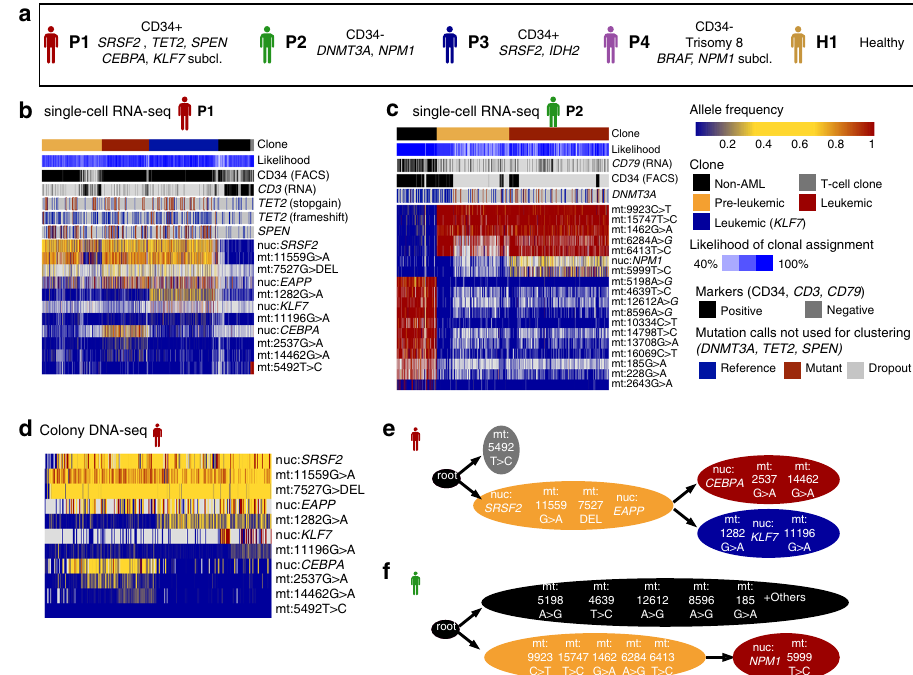
Fig. 2 Mitochondrial mutations serve as high-con fi dence clonal markers in AML. See also Supplementary Figs. 2 – 6. a Overview of the patients. CD34 + and CD34- indicate the dominant surface phenotype of the leukemic blasts (see Fig. 3b and Supplementary Fig. 2 for quanti fi cation). For each patient, genes containing mutations are printed in italic (see Supplementary Data 1 for a complete list). Subcl., sub-clonal mutation. b Heatmap depicting variant allele frequencies (color coded, see right of Fig. 2c for a key) observed in single-cell RNA-seq data of n = 1430 cells from P1. Gray indicates missing values. Cells and mutations are arranged according to the clustering result obtained by PhISCS 36 as described in the “ Methods ” section, Analysis of mitochondrial mutations and reconstruction of clonal hierarchies . Calculation of the likelihood is described in the same section. Mutations with low coverage (in TET2 , and SPEN ) were not included in the clustering and are depicted in the heatmaps as metadata, however, in all cases except TET2 frameshift there is quantitative evidence for their association with speci fi c clones (Supplementary Fig. 5b). For reproducing the computations, see the vignettes accompanying the mitoClone package. For mutations, nuc is nuclear genome; mt is mitochondrial genome. c Like panel b , but using n = 1066 cells from P2. DNMT3A is included as a low coverage mutation with signi fi cant association to the pre-leukemic and leukemic clone (Supplementary Fig. 5b). d Heatmap depicting variant allele frequencies (color coded, see legend to the right of Fig. 2c) observed in targeted DNA-seq data from n = 288 single-cell derived colonies from P1. e PhISCS 36 was run on the mutational data from P1 to reconstruct a clonal hierarchy, see the Methods section Analysis of mitochondrial mutations and reconstruction of clonal hierarchies. Take note that while the order of mutations is based on the PhISCS model, the grouping of mutations into clones is based on an arbitrary cutoff to provide a useful clustering for further analyses. See Clone in Fig. 2c legend for color codes. f Like e , but for hierarchies could be delineated, and a con fi dent assignment of cells to clones became possible (Fig. 2b, c and see Supplementary Fig. 3b for a quantitative analysis). Unlike genomic mutation calling from cDNA, identi fi cation of clonal identities from mitochondrial mutations is mostly not, and in one case weakly, affected by gene expression levels or library quality (Supplemen- tary Figs. 3c, d, 5c), and is possible at lower sequencing depths (Supplementary Fig. 5d – f), since mitochondrial genes are consistently highly expressed. DNA-sequencing from single-cell derived colonies (Patient 1, Fig. 2d). Across the patients, we identi fi ed clones carrying known